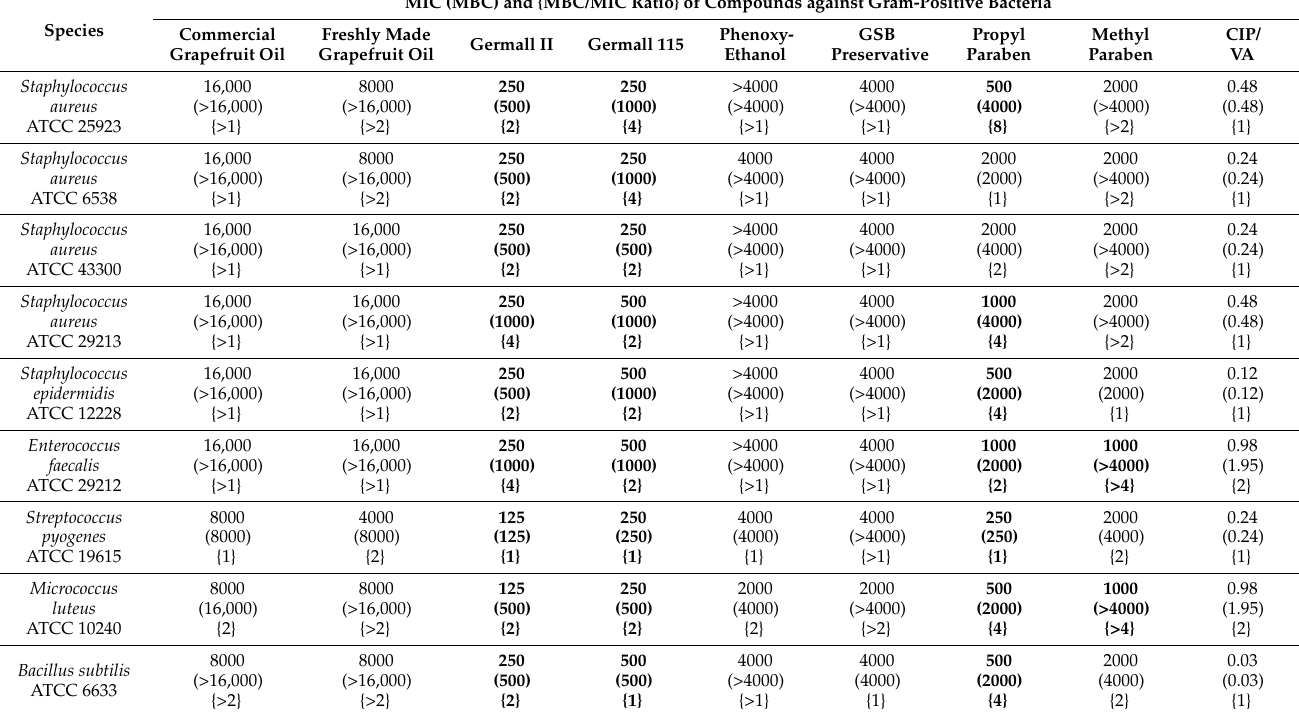
Table 2. The activity data of tested compounds expressed as MIC ( µ g/mL), MBC ( µ g/mL), and MBC/MIC ratio against the reference strains of Gram-positive